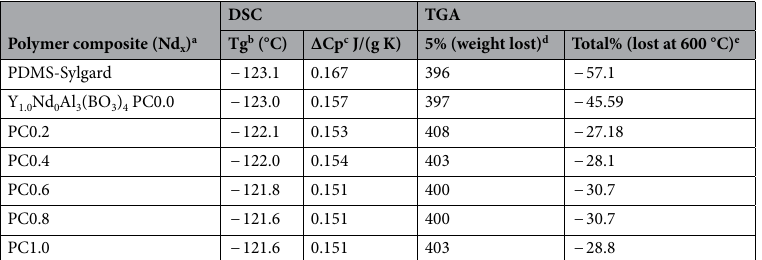
Polymer composite (Nd x )